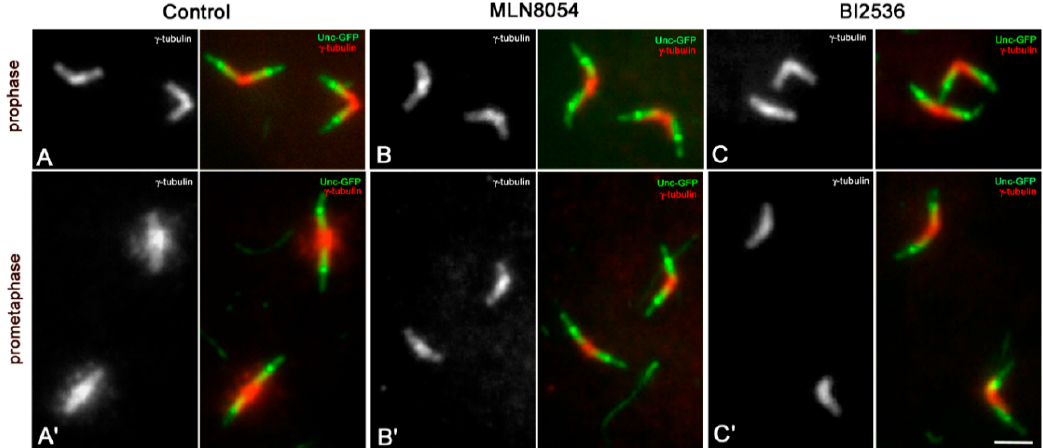
Figure 3. Aurora A and Polo/Plk1 kinase inhibition does not affect the accumulation of γ -tubulin in prophase spermatocytes. Double labelling with Unc-GFP shows that γ -tubulin is diffused along the whole centriole wall, with a distinct accumulation to the proximal regions of both the parent centrioles ( A ). The accumulation of γ -tubulin does not change following incubation with MLN8054 ( B ) and BI2536 ( C ), small molecules that inactivate the Aurora A and Polo/Plk1 kinases, respectively At the onset of the meiotic division the amount of γ -tubulin increased in control spermatocytes ( A’ ) but remains at the levels of the previous prophase after depletion of Aurora A ( B’ ) and Polo/Plk1 ( C’ ). Scale bar: 1 μ m.